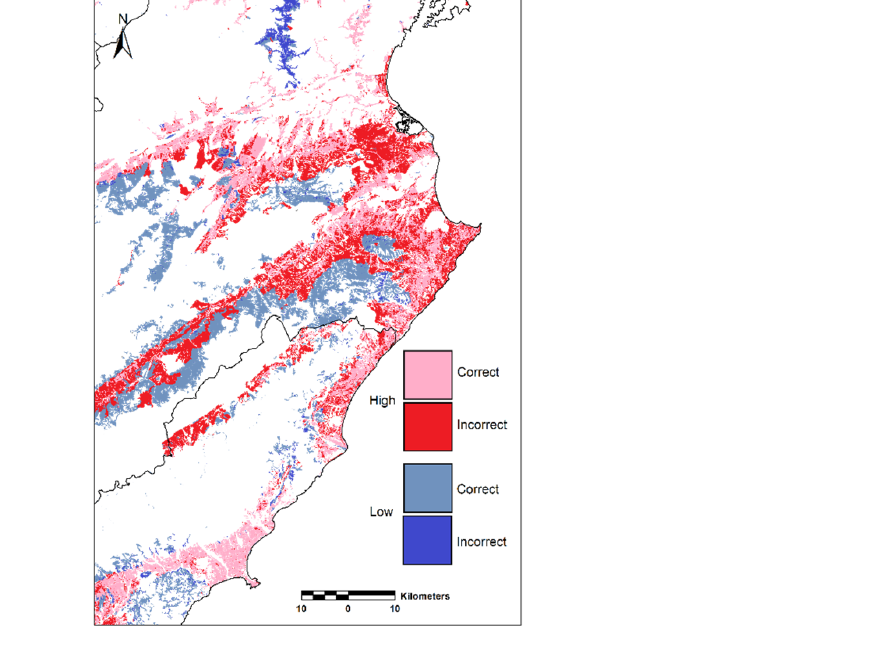
Figure 12. A view of Marlborough grassland as classified in LCDB and according to median NDVI.